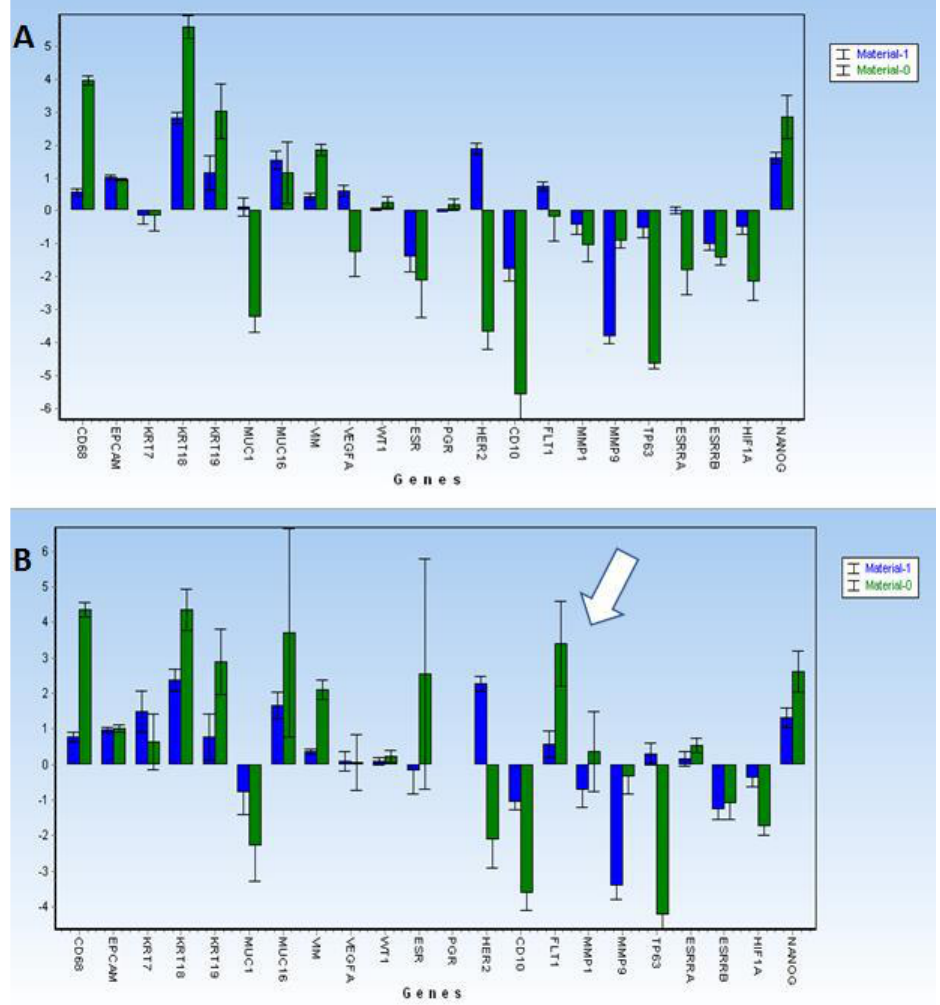
Figure 3. Gene expression profiling data displayed for CECs when compared to white blood cells (WBC). ( A ) Gene expression profiling data displayed for all CECs tested in the study ( n = 52) ( B ) Gene expression profiling data for high-positive CEC ( n = 13) samples when compared to the white blood cell fraction (WBC). In super-positive CEC samples, FLT1 was significantly elevated (see white arrow). The expression of other genes reflects the comparison between WBC and CECs in all tested samples (see Figure S1A, Supplementary Materials).